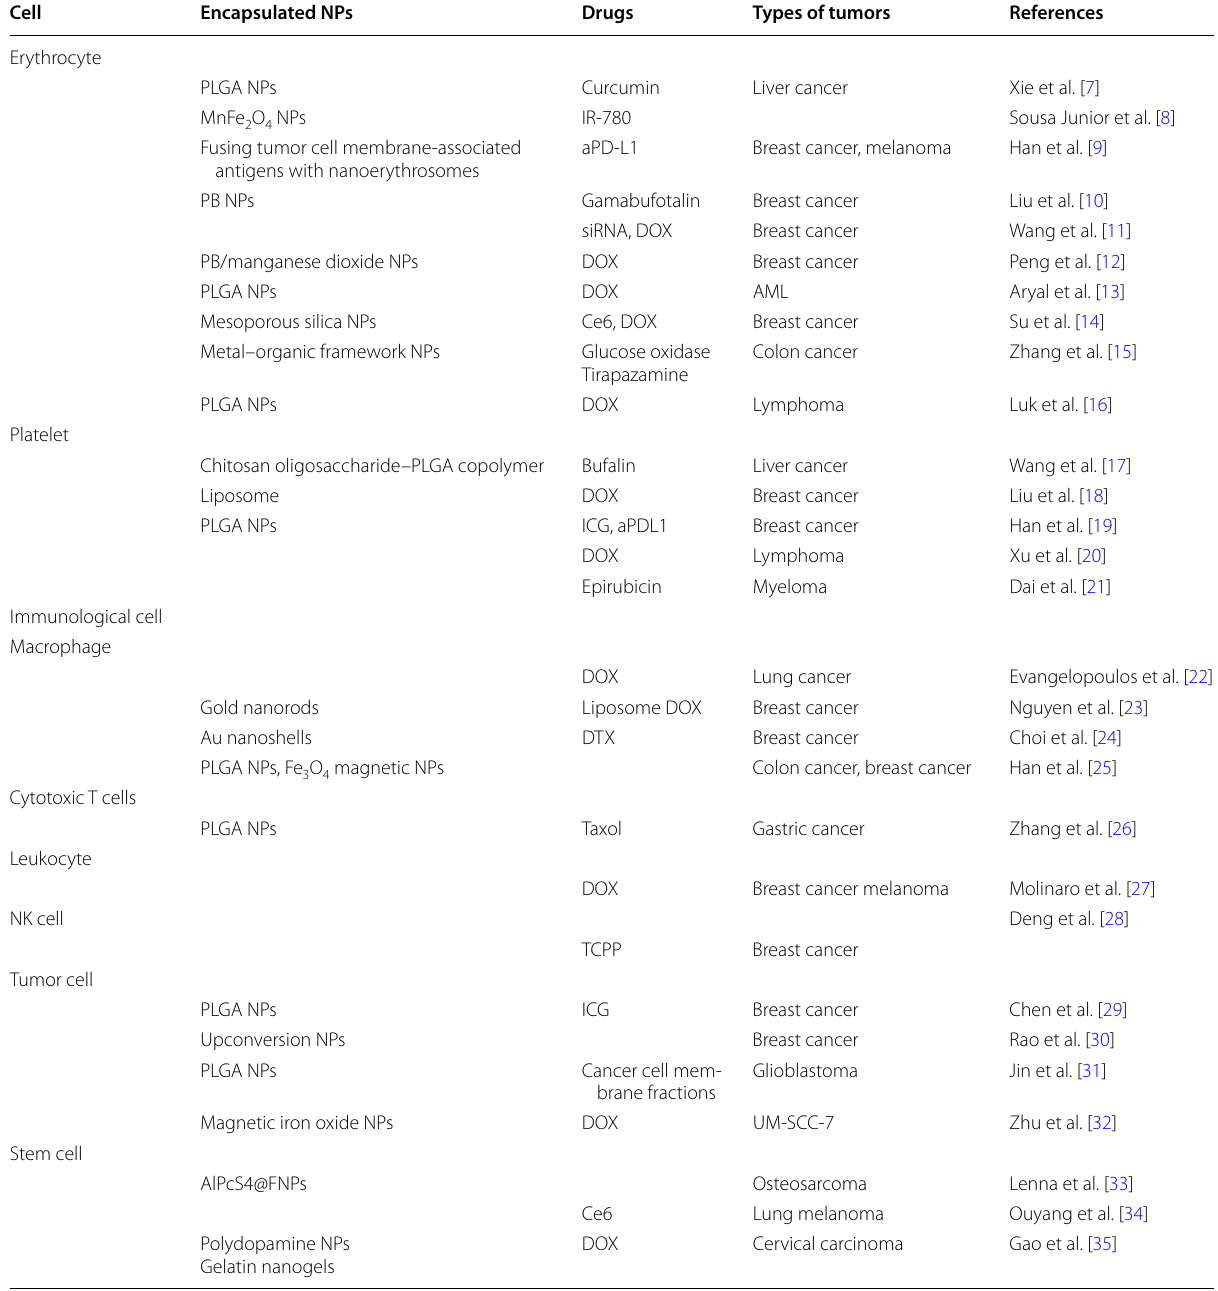
Table 1 Application of drug delivery technology based on different cells in cancer